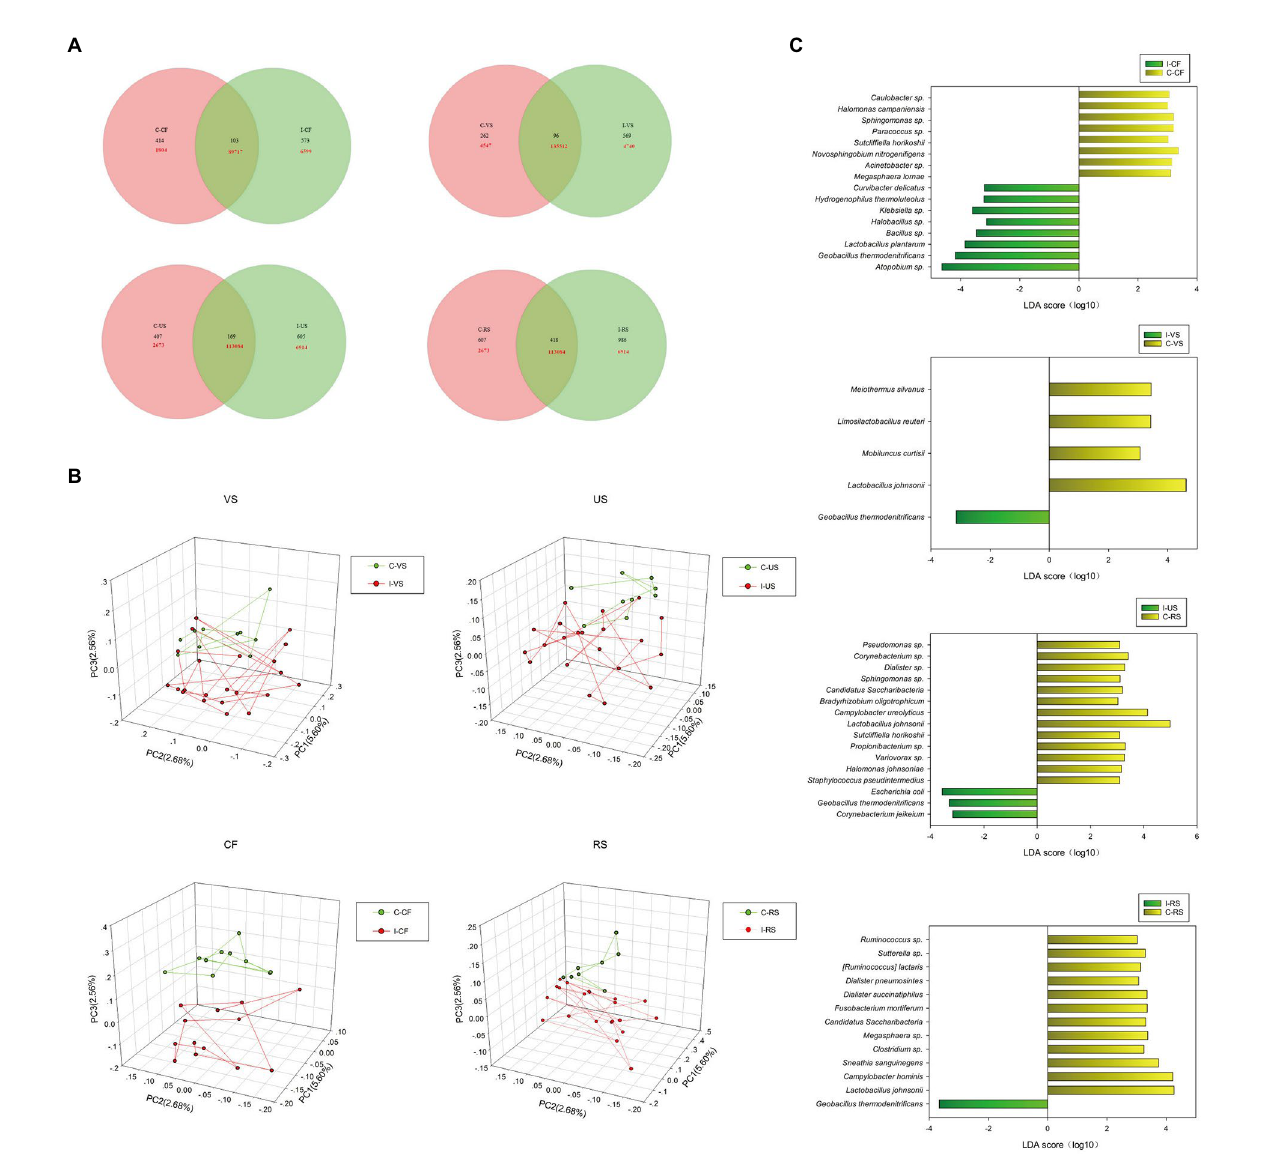
FIGURE 2 Differences in microbial diversity of cervix, vagina, urethra, rectal between infertile patients and controls group. (A) Venn diagram shows the OTUs and sequences shared by different groups at different sampling sites. (B) PCA plot based on the relative taxon abundance in cervix, vagina, urethra and rectal samples from infertility and control groups. (C) LEfSe analysis detected signature microorganisms at different sampling sites, LDA > 2, yellow shows the positive LDA score indicating enrichment in infertility patient samples; gray shows the negative LDA score indicates the taxa enriched in the control